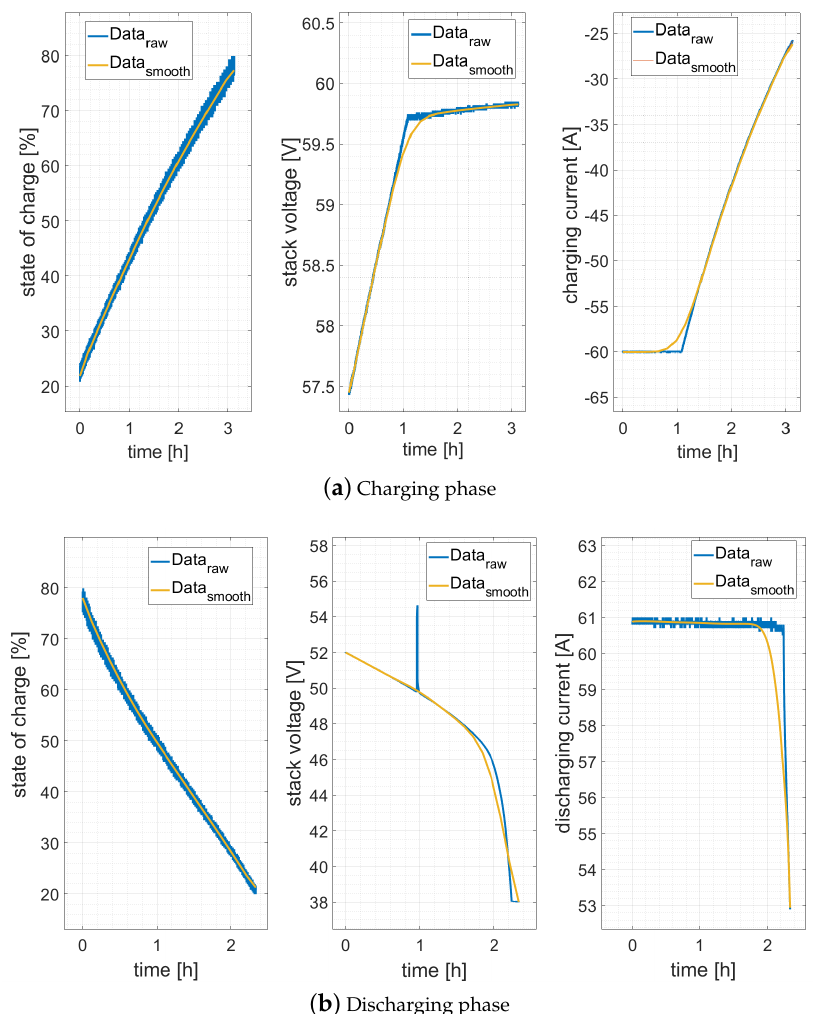
Figure 5. Comparison of the raw data and modified data of the 30 A cycle for the: ( a ) charge phase; ( b ) discharge